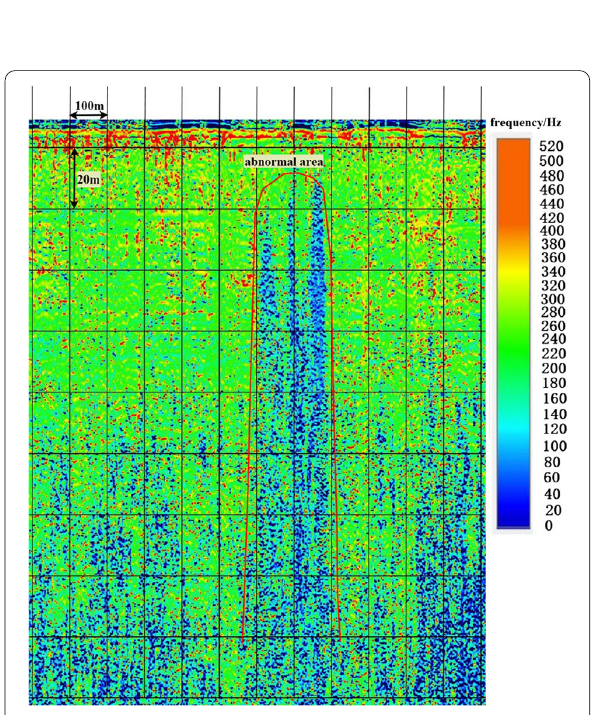
Fig. 10 The acoustic profile in survey area profile1, and the seismic attribute is instantaneous frequency for Fig.